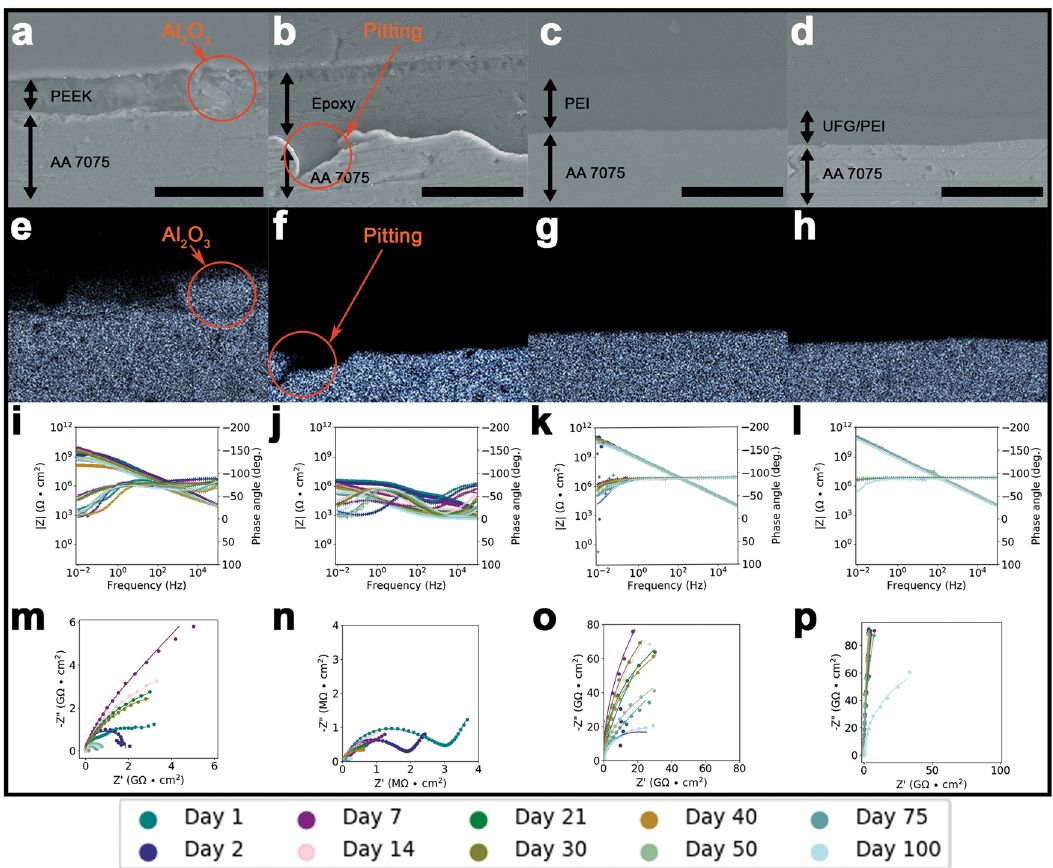
Fig. 5 Electrochemical processes, interface characterization, and corrosion mechanisms in coated AA 7075 substrates. Post-exposure SEM cross-sectional views of coatings comprising ( a ) PEEK, ( b ) epoxy (2011) variation with no fi llers, ( c ) PEI, and ( d ) 3 wt.% UFG/PEI, respectively with the scale bars measuring 50 µm distance, on AA 7075 substrates monitored across 100 days of exposure to 3.5 wt.% aqueous solutions of NaCl. Aluminum EDX maps of coatings comprising ( e ) PEEK, ( f ) epoxy, ( g ) PEI, and ( h ) 3 wt.% UFG/PEI. Bode plots corresponding to coatings comprising ( i ) PEEK, ( j ) epoxy, ( k ) PEI, and ( l ) 3 wt.% UFG/PEI. Nyquist plots for coatings comprising ( m ) PEEK, ( n ) epoxy variation, ( o ) PEI, and ( p ) 3 wt.% UFG/PEI monitored across 100 days of exposure to 3.5 wt.% aqueous solutions of